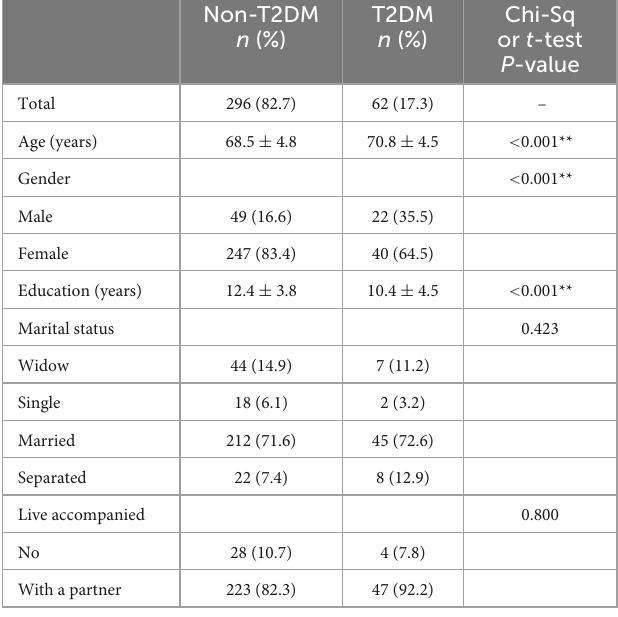
TABLE 1 Sociodemographic characteristics of the participants comparing people without Type 2 Diabetes Mellitus and patients with Type 2 Diabetes